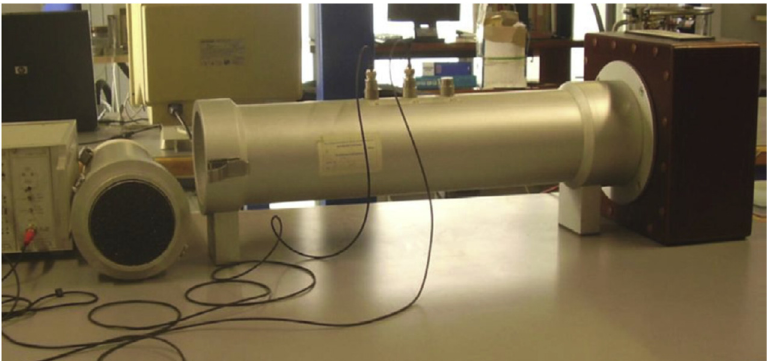
Figure 3. Impedance tube for measuring the normal sound absorption coefficients at the acoustic laboratory of the University of Campania “Luigi Vanvitelli”, Department of Architecture and In- dustrial Design.